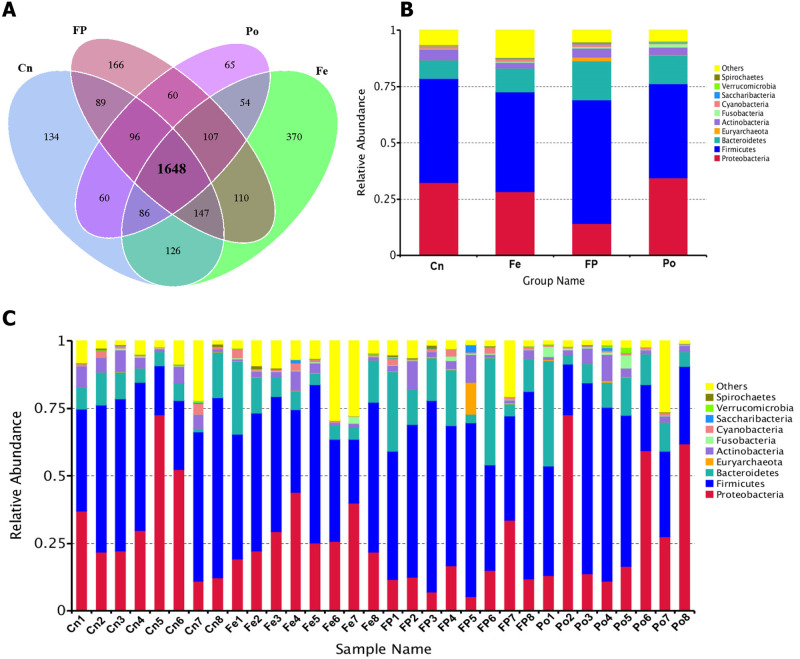
Venn Graph representation of the shared and exclusive OTUs at the 97% similarity level among the three groups of fecal microbiota (A). Bar plots analysis shows relative abundance of fecal microbiota at the phylum level in each group (B) and in each sample (C).